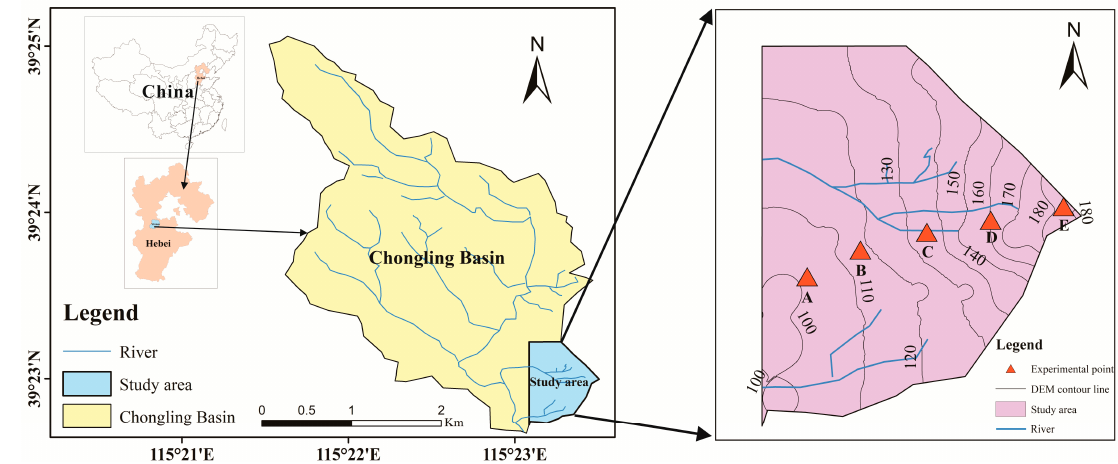
Figure 1. Location of the Chongling catchment study area (with its location within China) and the experimental plots (A: bottom–, B: lower–, C: mid–, D: upper–, and E: top–slope positions). DEM: digital elevation model.